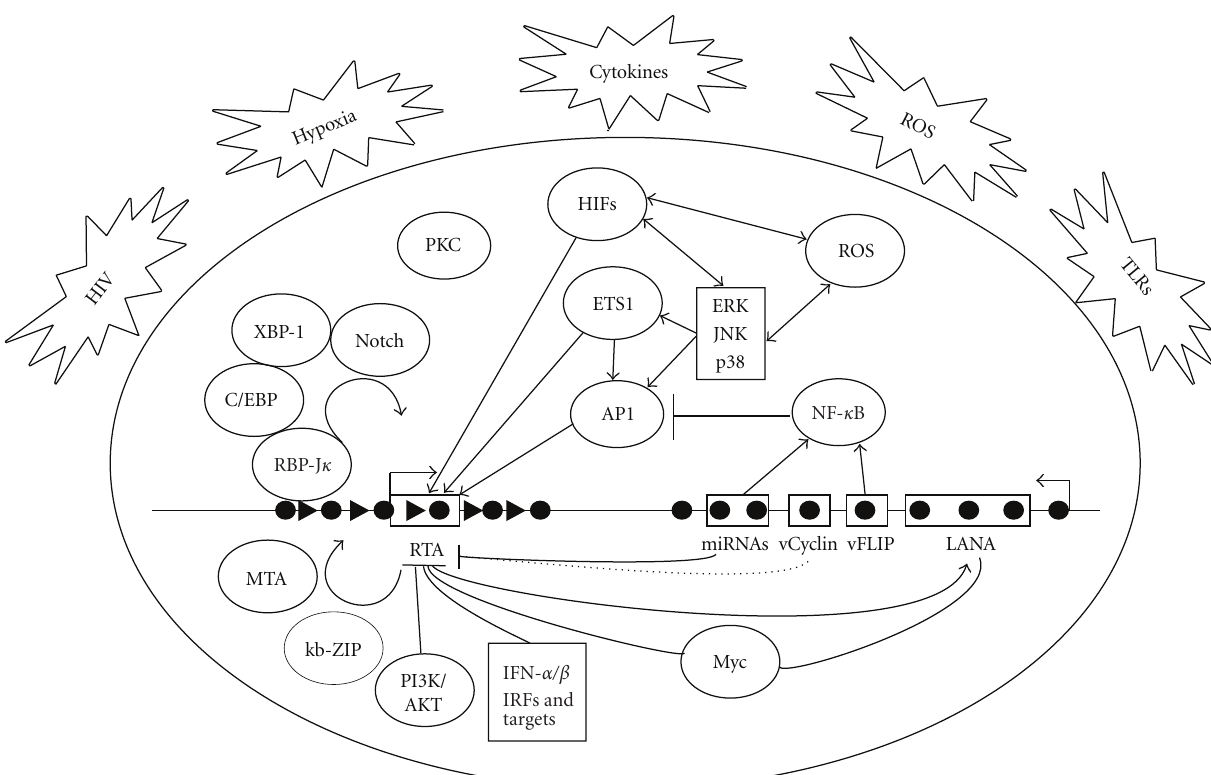
Figure 1: Schematic illustration of mechanisms of KSHV latency and reactivation. During primary infection, KSHV activates innate immune responses such as IFN- α / β and IRFs and multiple cell survival pathways including NF- κ B, c-Myc, and PI3K/AKT, all of which repress KSHV lytic replication. Expression of KSHV latent products including LANA, vCyclin, vFLIP, and a cluster of miRNAs also inhibits KSHV lytic replication. As a result, KSHV establishes latency following primary infection. During latency, most parts of viral genome are epigenetically silenced and contain both active and repressive histone marks (black triangle) with the exception of the latent locus, which is transcribed and contains only active histone marks (black cycle). KSHV latent products enhance/maintain latency by promoting cell survival and facilitating the viral episome replication and segregation. Several physiological factors including hypoxia, HIV infection, inflammatory cytokines, oxidative stress, and ROS can induce RTA expression by activating specific cellular pathways and transcriptional factors including MEK/ERK, JNK, p38, AP-1, Ets-1, HIF1/2, PKC, and Notch. RTA interacts with several host proteins such as XBP-1, Notch, and C/EBP α , as well as viral proteins such as MTA and kb-ZIP, to quickly remove the repression histone marks on KSHV genome, resulting in the expression of viral lytic genes and activation of the entire viral lytic transcriptional